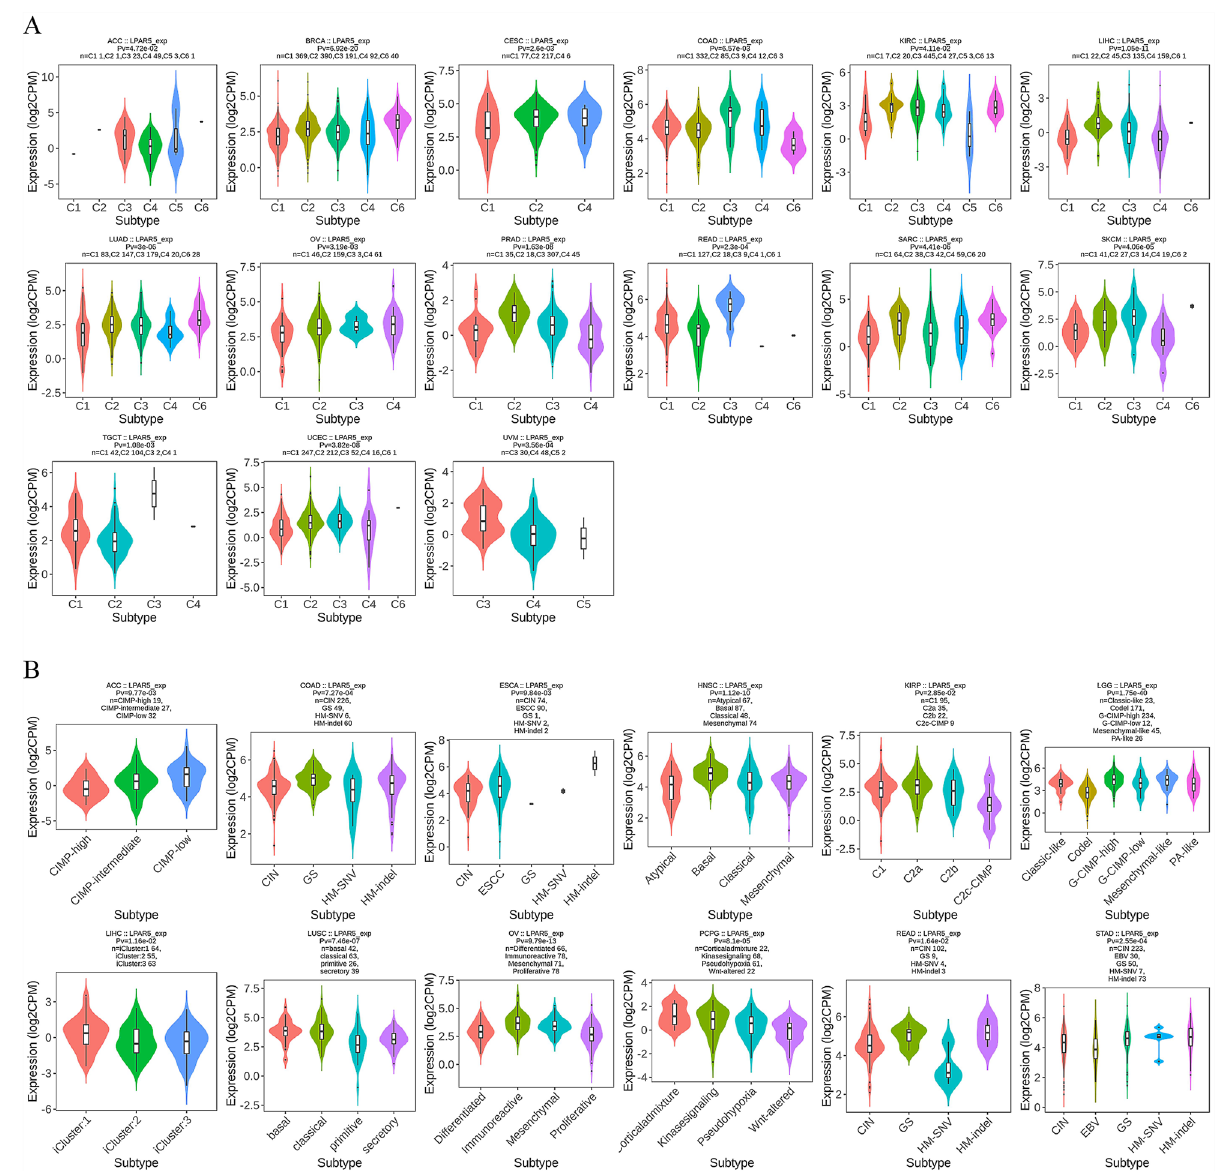
Figure 8. The correlation between LPAR5 expression levels and immune and molecular subtypes of various cancer types. ( A ) Immune subtypes. ( B ) Molecular subtypes. [Figures created by TISIDB database (http:// cis. hku. hk/ TISIDB/ index.